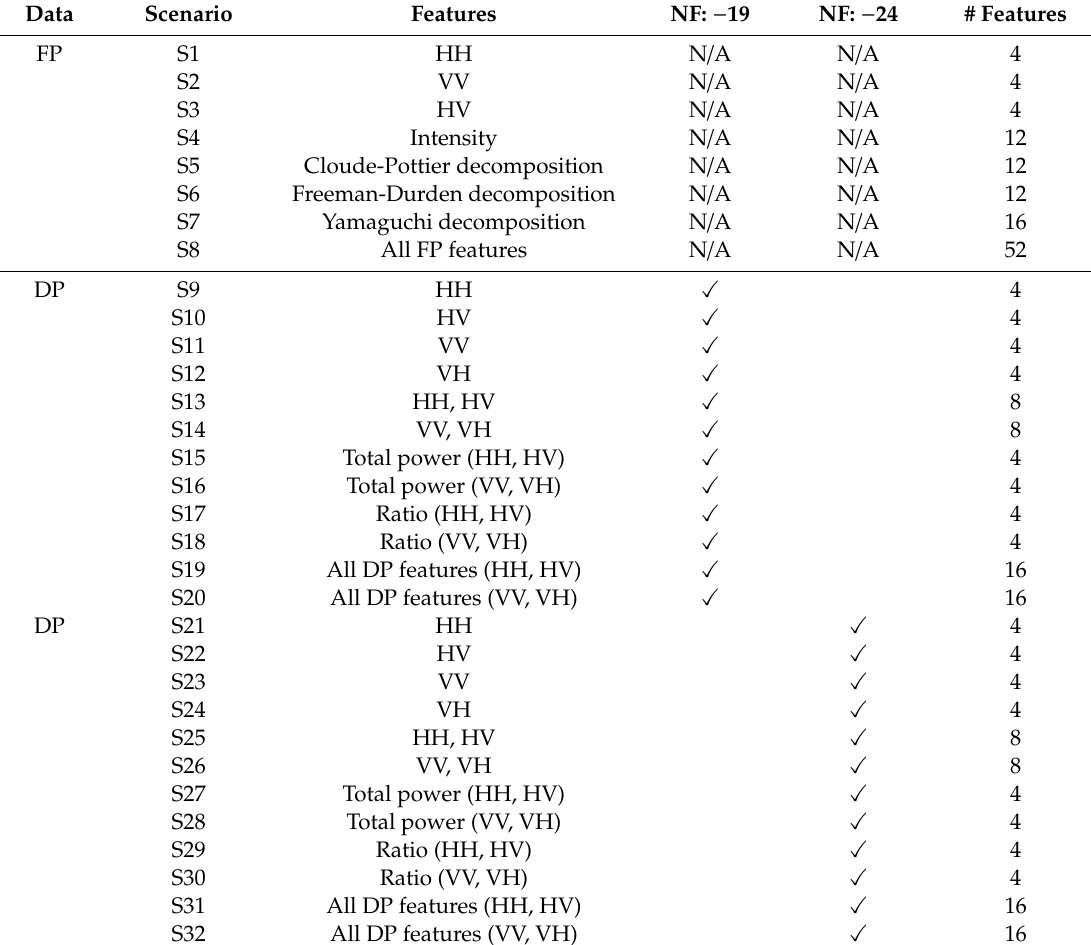
Table 3. Di ff erent pixel-based classification scenarios examined in this